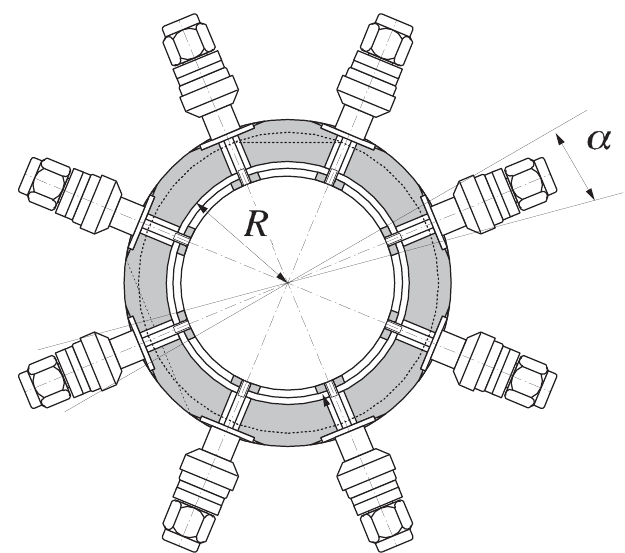
FIG. 1. Schematic cross-sectional drawing of the energy- spread